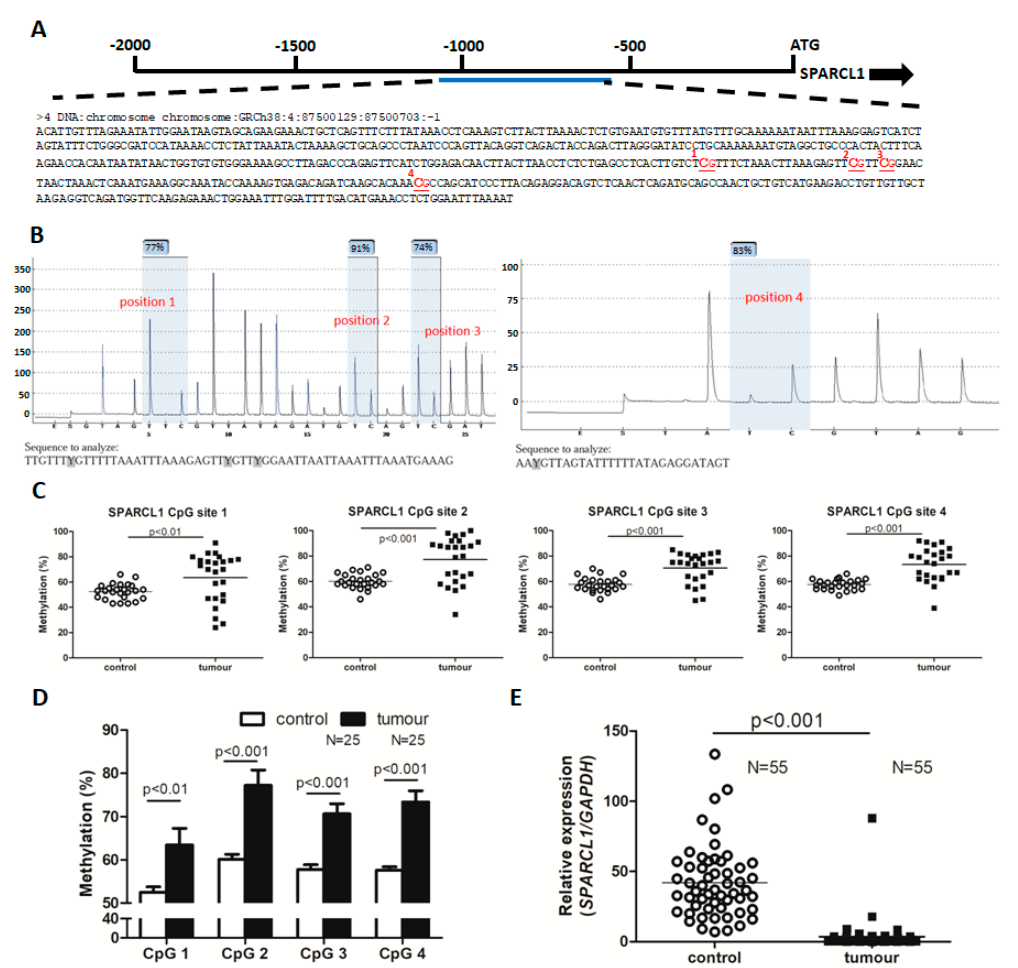
Figure 2. SPARCL1 associated with hyper-DMR was down-regulated in the upper urinary tract urothelial carcinoma. ( A ) Schematic view of the SPARCL1 locus. There were four CpG sites in the SPARCL1 promoter region. ( B ) Four methylation sites in the SPARCL1 promoter region identified by bisulphite pyrosequencing. ( C , D ) SPARCL1 CpG site methylation levels in the control (adjacent urothelium, n = 25) and the paired tumor samples. ( E ) Quantitative polymerase chain reaction from UTUC ( n = 55 patients) and their matched adjacent normal tissues.